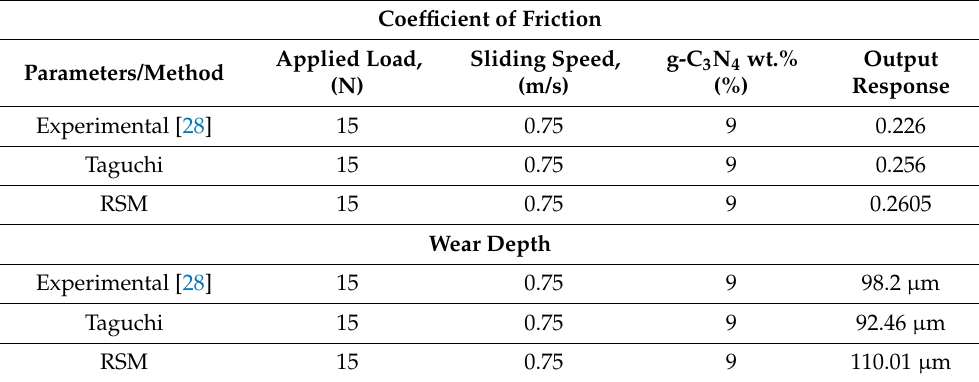
Table 8. Calculated coefficient of friction and wear depth from different methods.